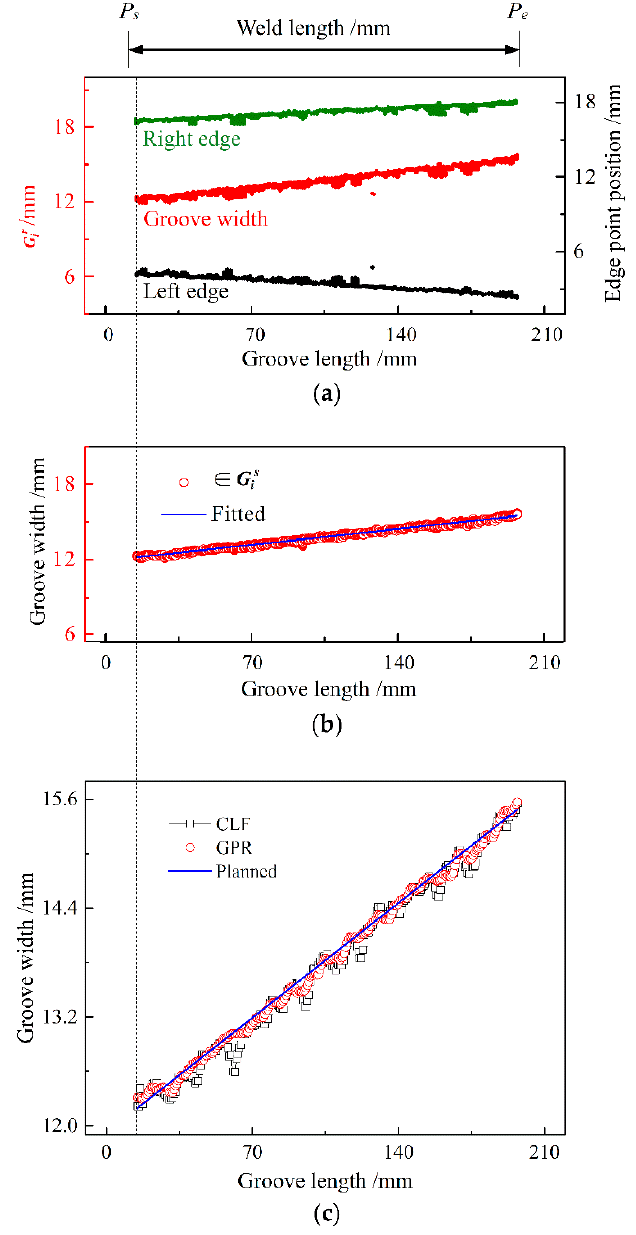
Figure 10. Detected results of width-varying groove: ( a ) edge point positions and instantaneous groove widths containing 269 sets of G i r ; ( b ) true data belonging to G i s and fitting line of the true data; ( c ) comparison of detected groove width values with the planned ones. Table 4. Comparison of detected results for width-varying